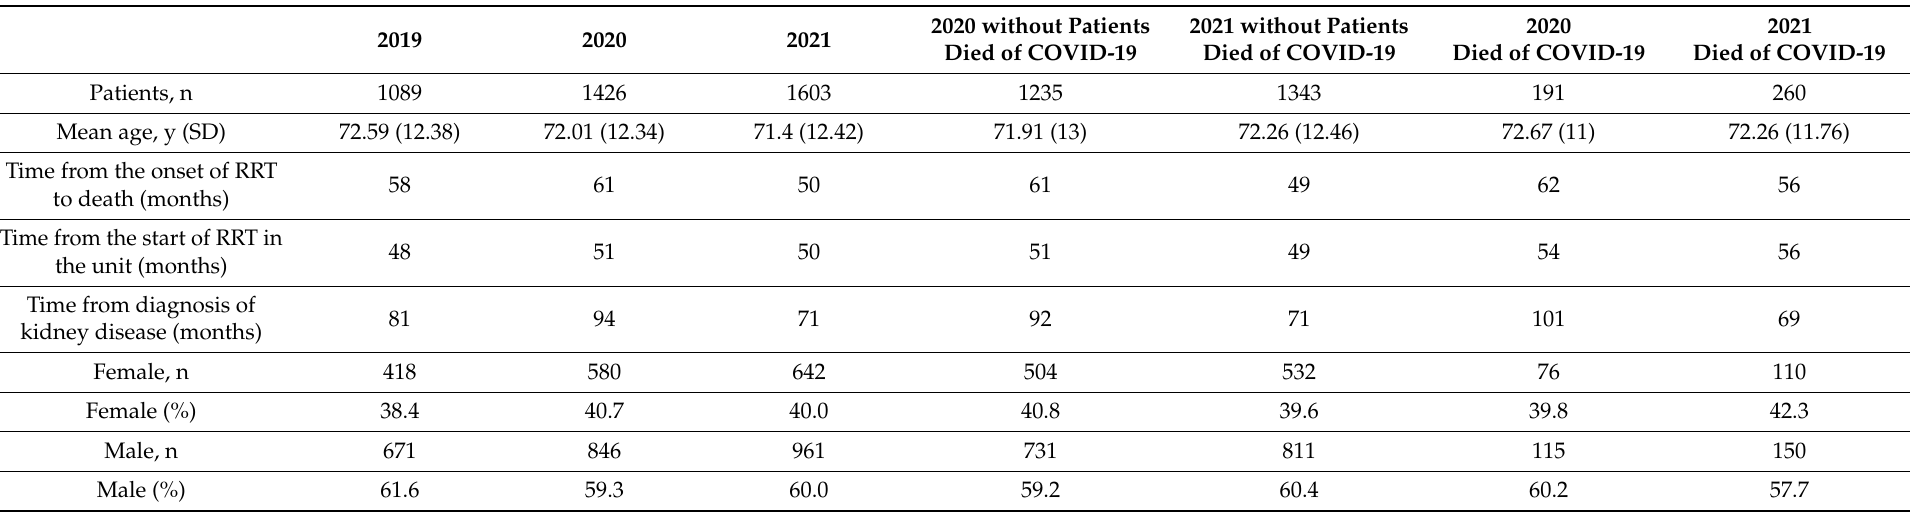
Table 5. Characteristics of deceased patients in 2019, 2020, and 2021 in relation to